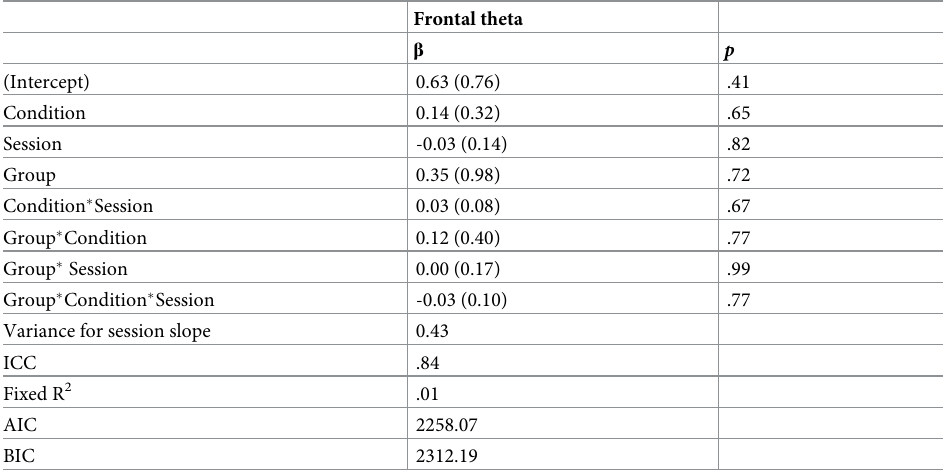
Table 2. Full MLMs of Fm θ during Go-NoGo shooting